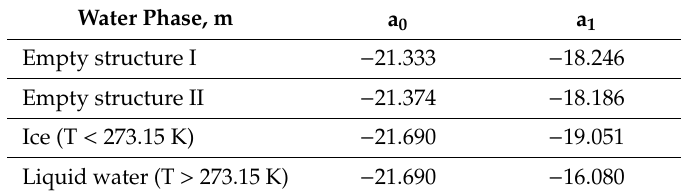
Table 1. Parameters for dimensionless chemical potential functions in Equation